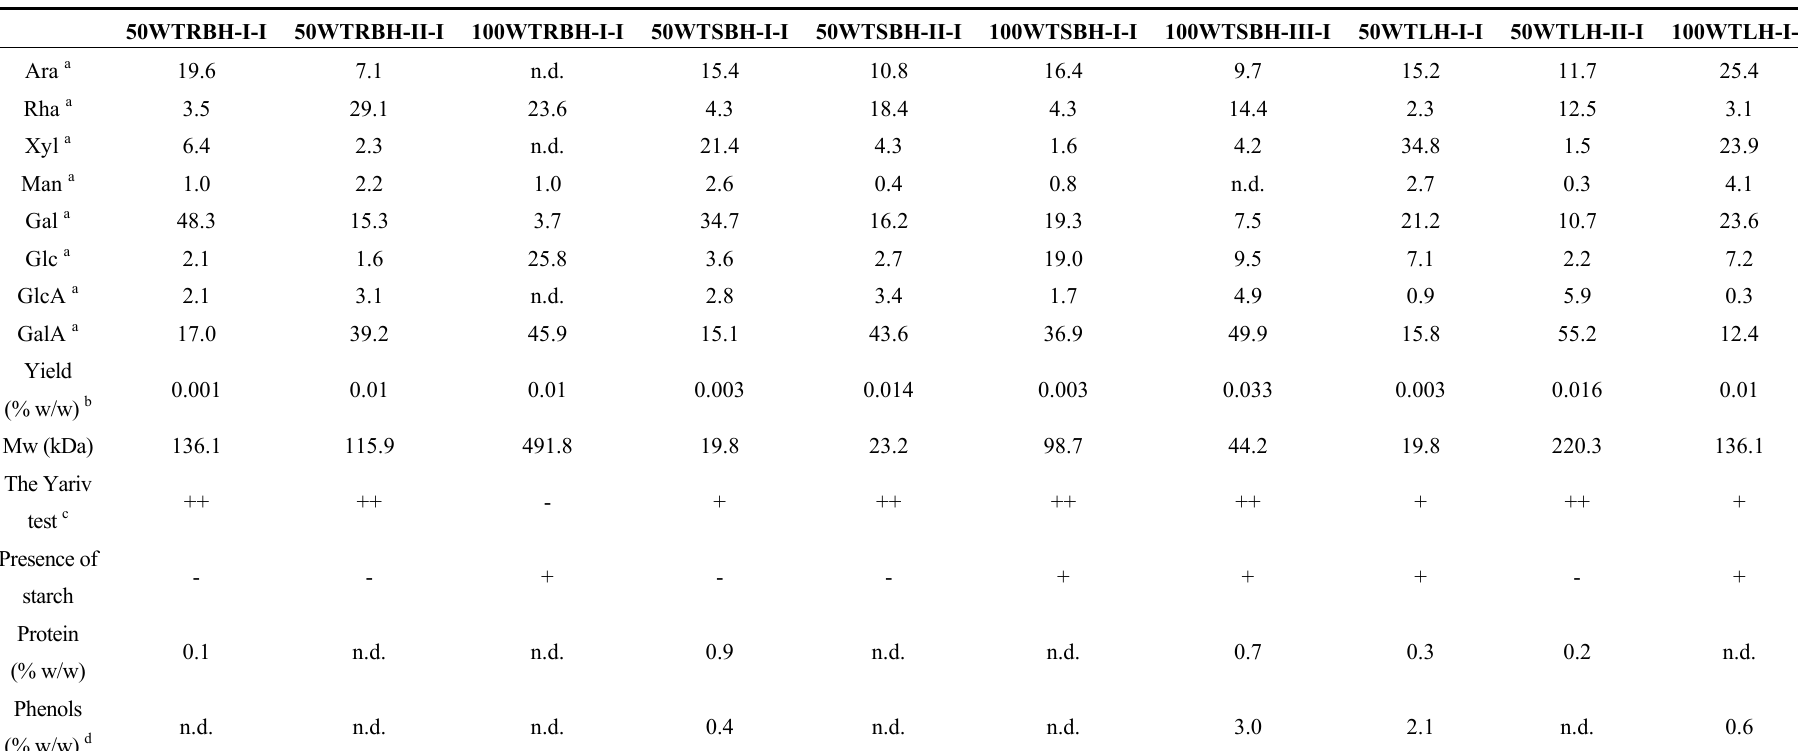
Table 2. Characterizations of polysaccharide fractions isolated from root bark, stem bark and leaves of T. macroptera after ion exchange chromatography and gel